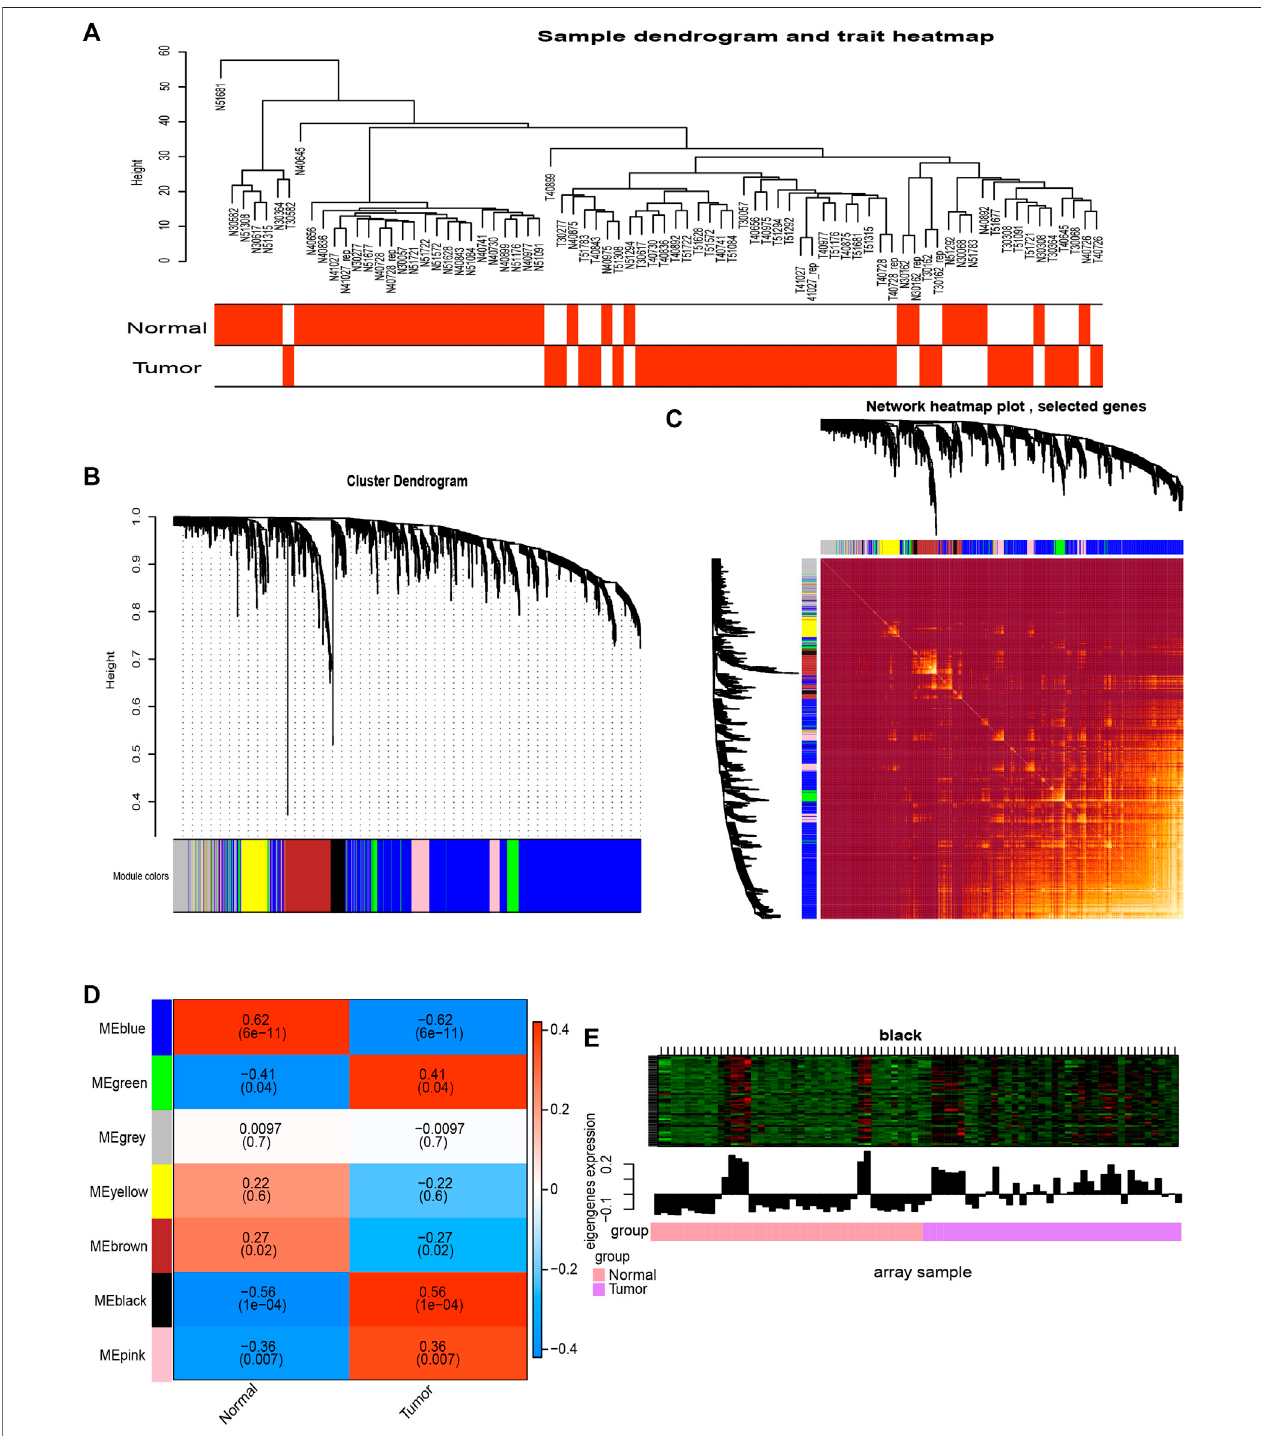
FIGURE2| Co-expressionanalysisofMEsfromtheGSE15471data. (A) ClusteringtreeofPCsamplesintheGSE15471data. (B) GenedistributionintheWGCNA networkanalysis. (C) HeatmapplotofthetopologicaloverlapintheMEsnetwork. (D) Analysisoftherelationshipsbetweengenesinmodulesbetweentumorandnormal samples. (E) In the black module, for most genes, expression in the tumor samples was higher than that in the normal samples.